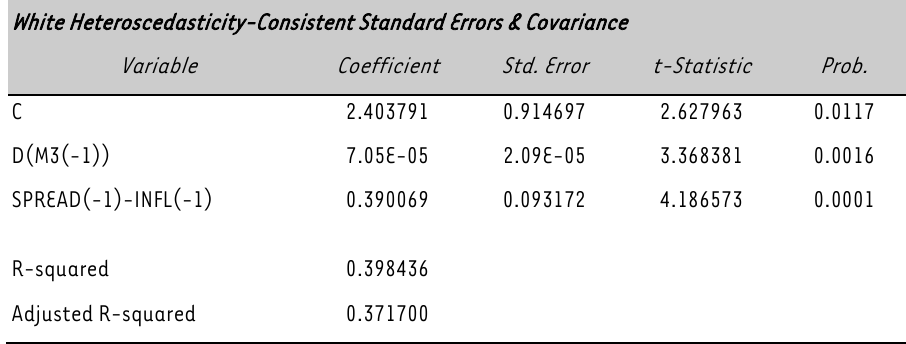
TABLE 4: Regression results for the domestic financial sector component Dependent Variable: D(COIN)